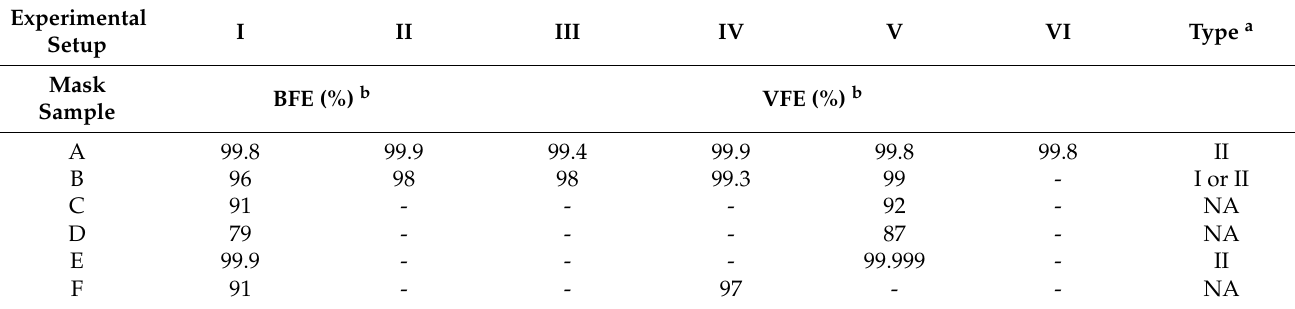
Table 3. Average bacterial (BFE) and viral filtration efficiency